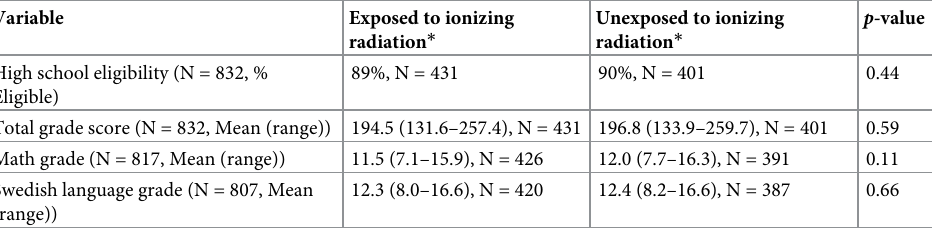
Table 2. Simple comparisons of participants exposed and unexposed to ionizing radiation in high school eligibil- ity, total grade score, grade in mathematics and the Swedish language, Chi-square test and students t -test. Variable